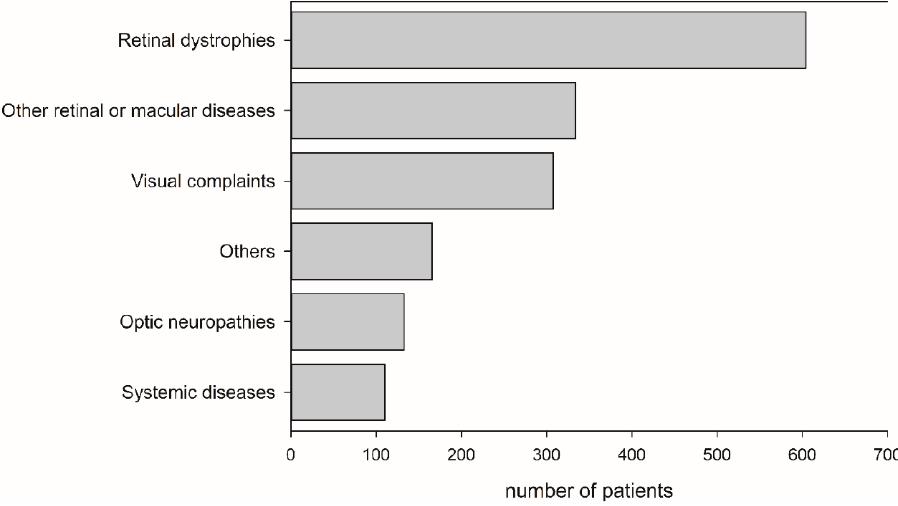
Figure 2. Cumulative numbers of patients in six diagnosis groups from September 2012 to December 2019 in his single tertiary medical